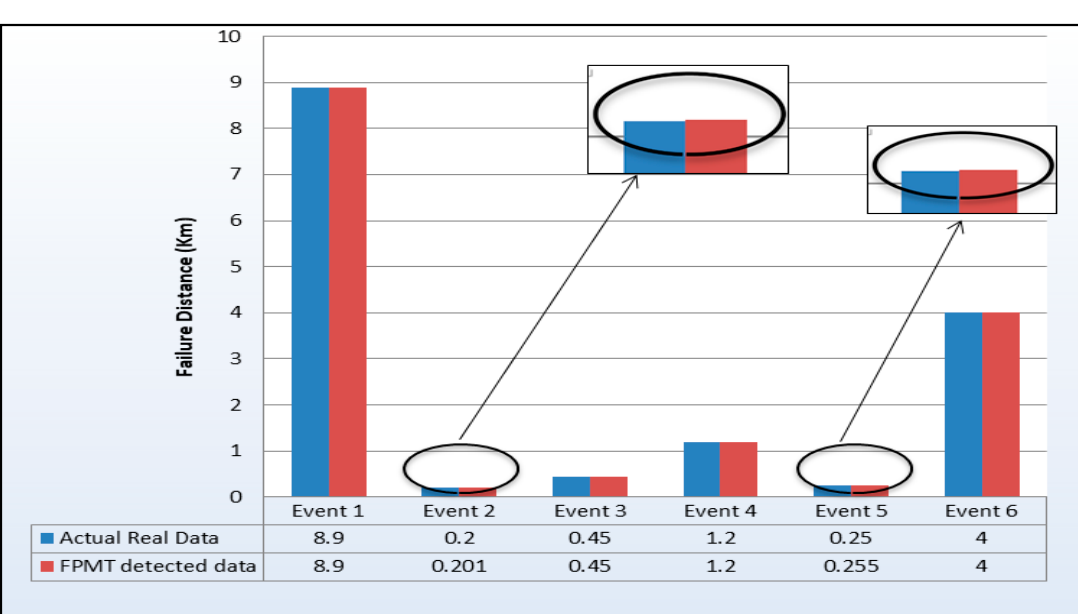
Figure 14. The real fault location and detected fault location using improved FPMT technique.